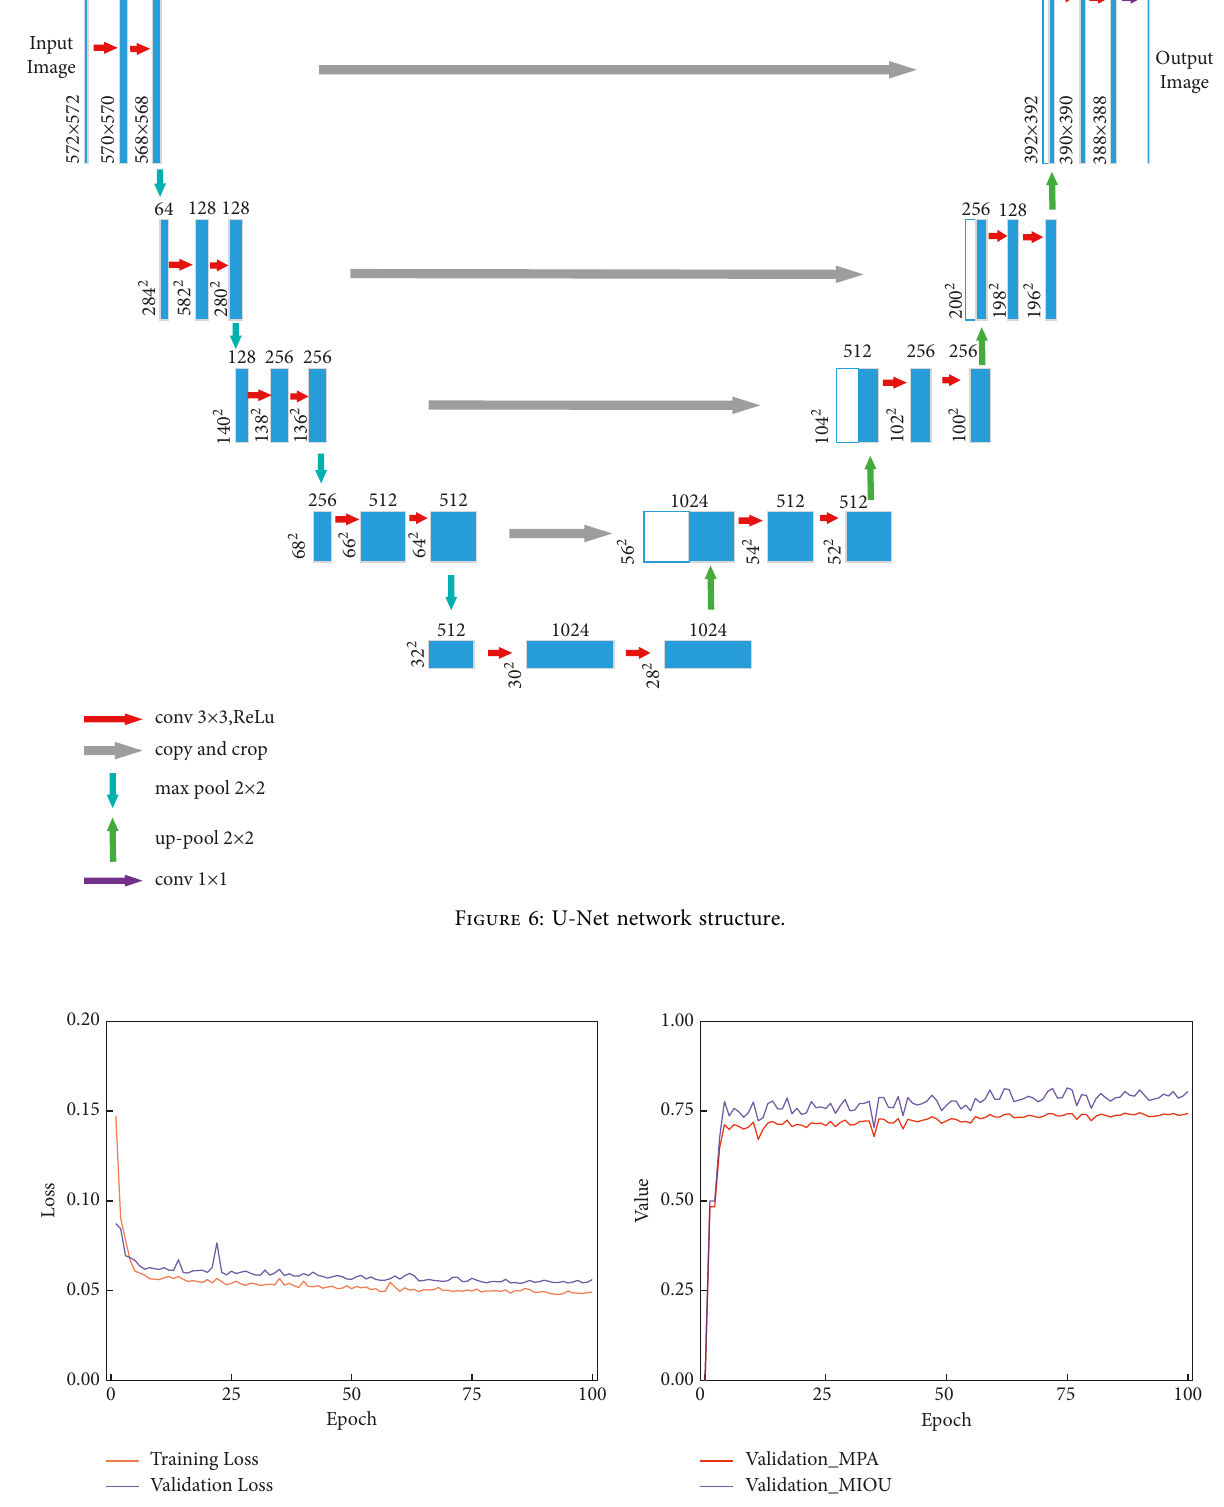
Figure 7: U-Net network model correlation curves: (a) loss curves; (b) MPA curve and MIOU